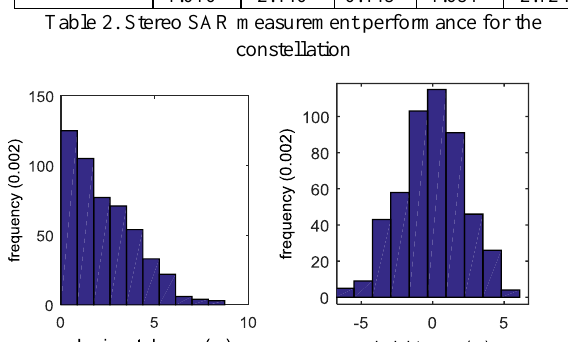
Table 2. Stereo SAR measurement performance for the constellation